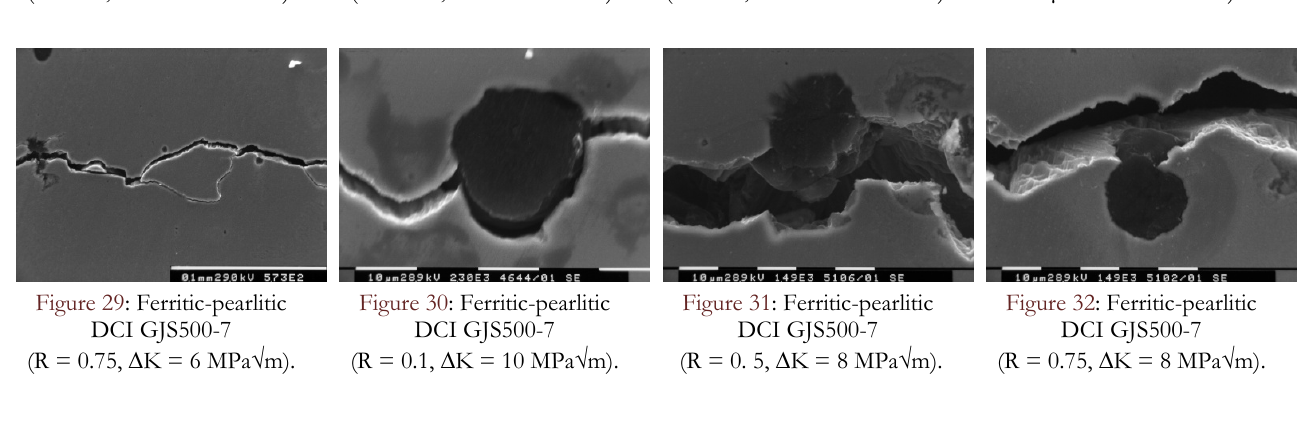
Figure 25: Pearlitic DCI (R = 0.1,  K = 12 MPa √ m).